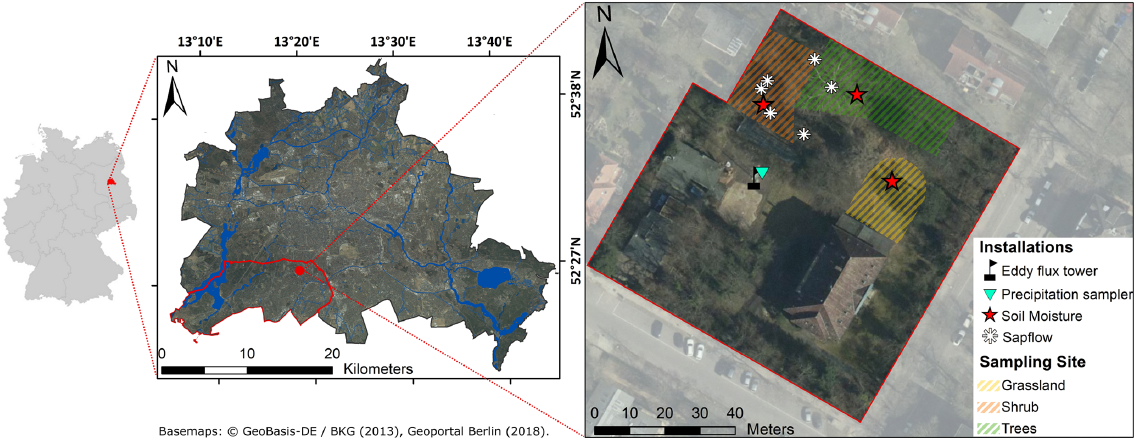
Figure 1. Location of Berlin within Germany (left); location of the district of Steglitz-Zehlendorf and the SUEO (red) with Berlin’s surface waters in blue (middle); and the SUEO (right) with vegetation plots and installations of soil moisture and sap flow measurements, precipitation sampler and eddy flux tower.